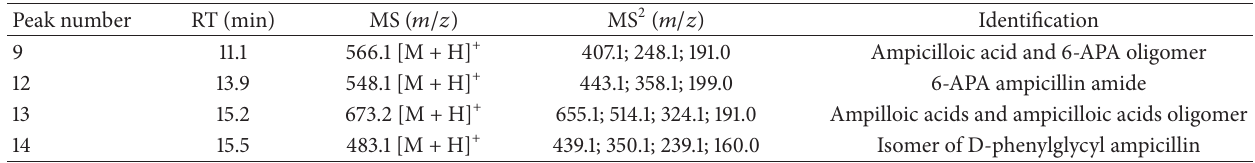
Table 3: Results of identification of the unknown related substances in ampicillin